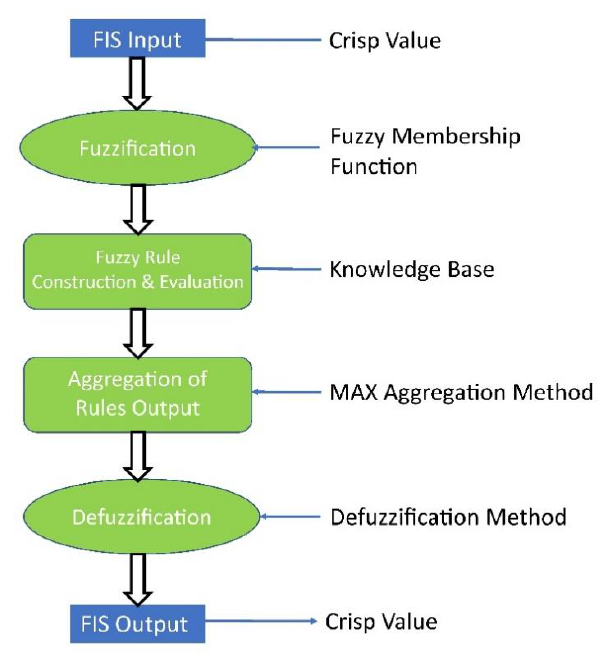
Figure 1. Fuzzy Inference System (FIS) procedures.